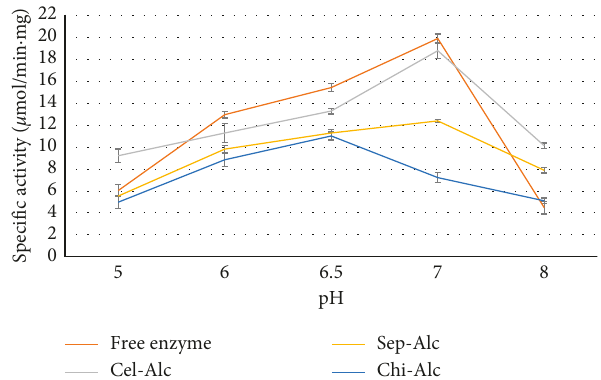
Figure 5: Specific hydrolytic activity of alcohol-immobilized samples with varying temperatures (pH 7.0 and [S] (cid:31)